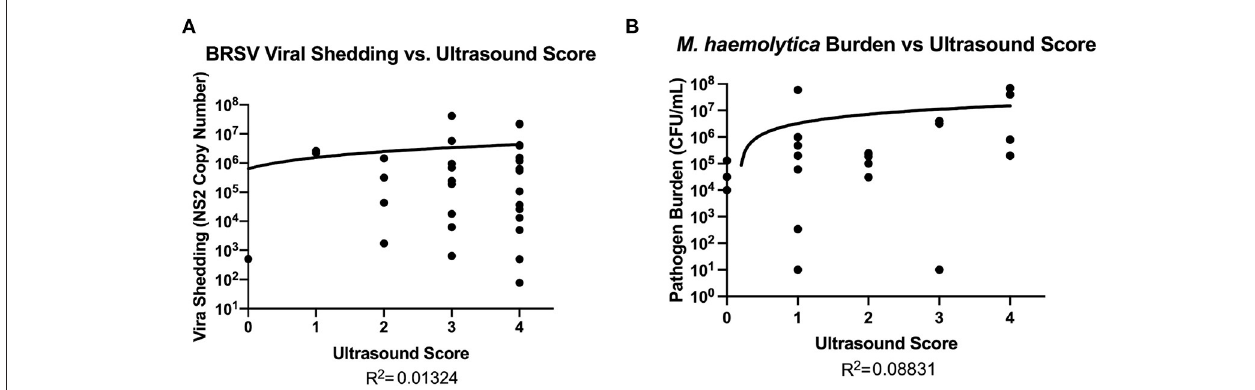
FIGURE 6 | Relationship between pathogen burden and TUS score. For BRSV–infected calves (A) , qRT-PCR was performed on nasal swabs for the BRSV NS2 gene to quantify the amount of virus being shed in nasal secretions on day 7. For M. haemolytica –infected calves (B) , quantitative culture was performed using samples of lung tissue to estimate bacterial lung burden.